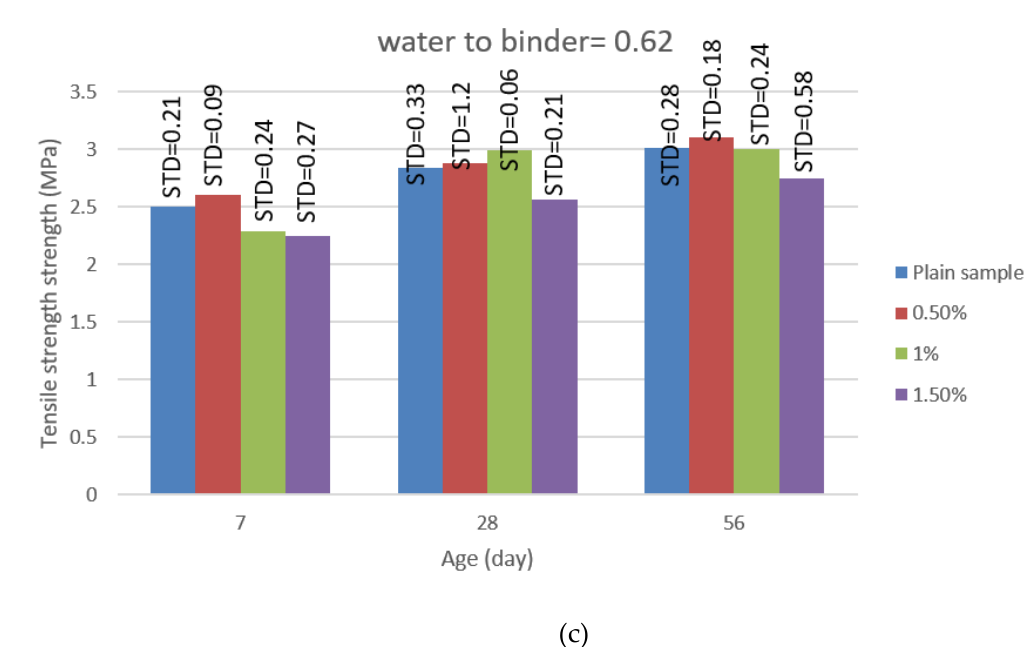
Figure 9. Tensile strength vs. age for water-to-binder ratios of ( a ) 0.44, ( b ) 0.49, and ( c ) 0.62.